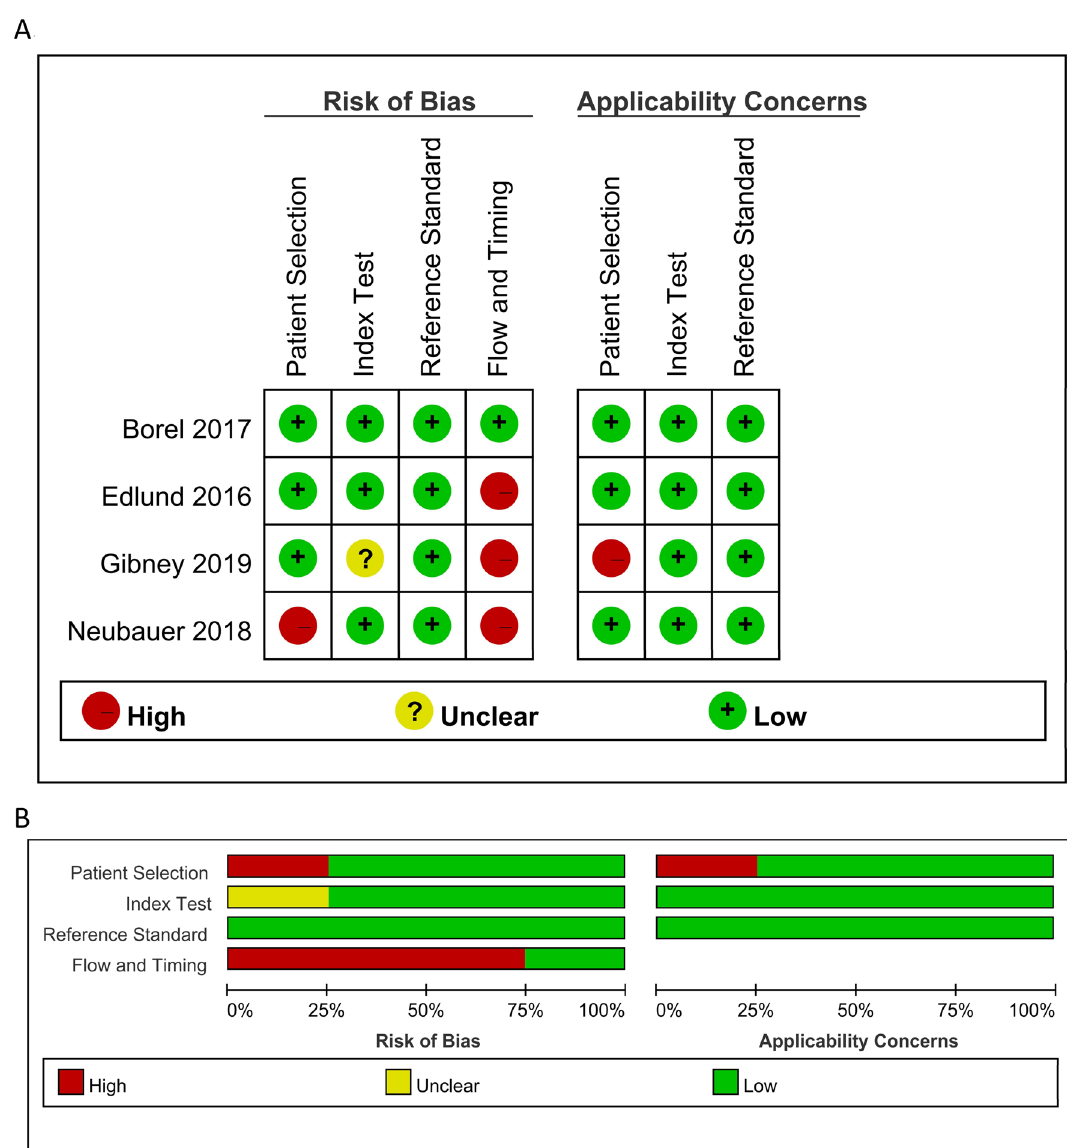
Figure 2. Methodological quality of included